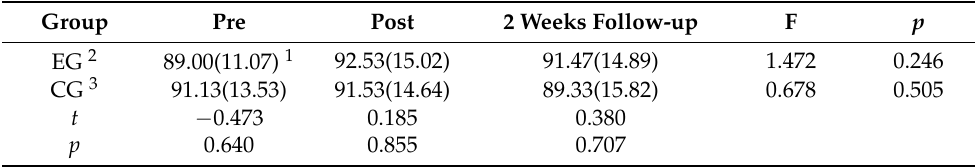
Table 9. Changes in stride length time by the